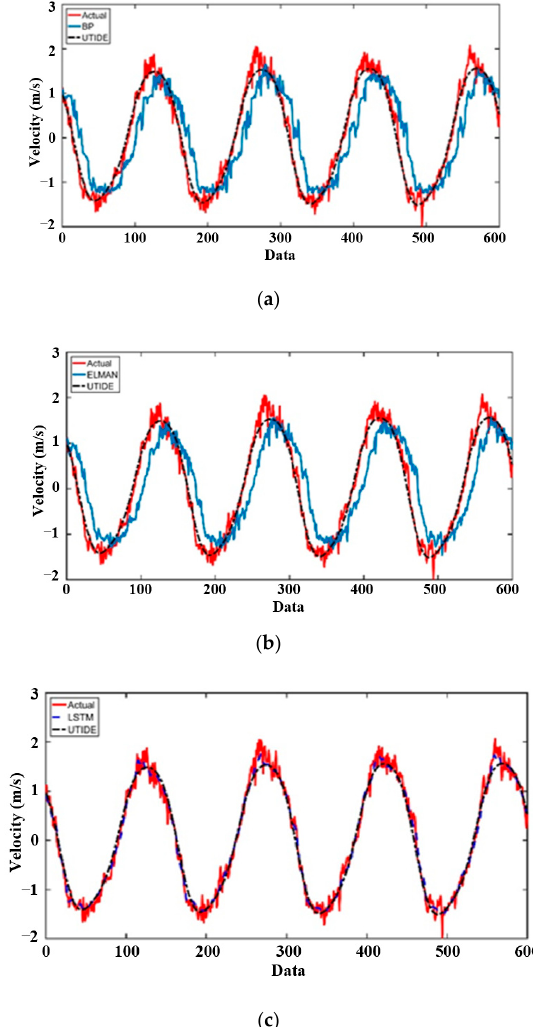
Figure 14. Comparison results of the single input prediction method by using three machine learning algorithms and UTide (30 m under sea surface). ( a ) Comparison of the BP method, UTide method, and actual value, ( b ) Comparison of the ELMAN method, UTide method, and actual value, ( c ) Comparison of the LSTM method, UTide method, and actual